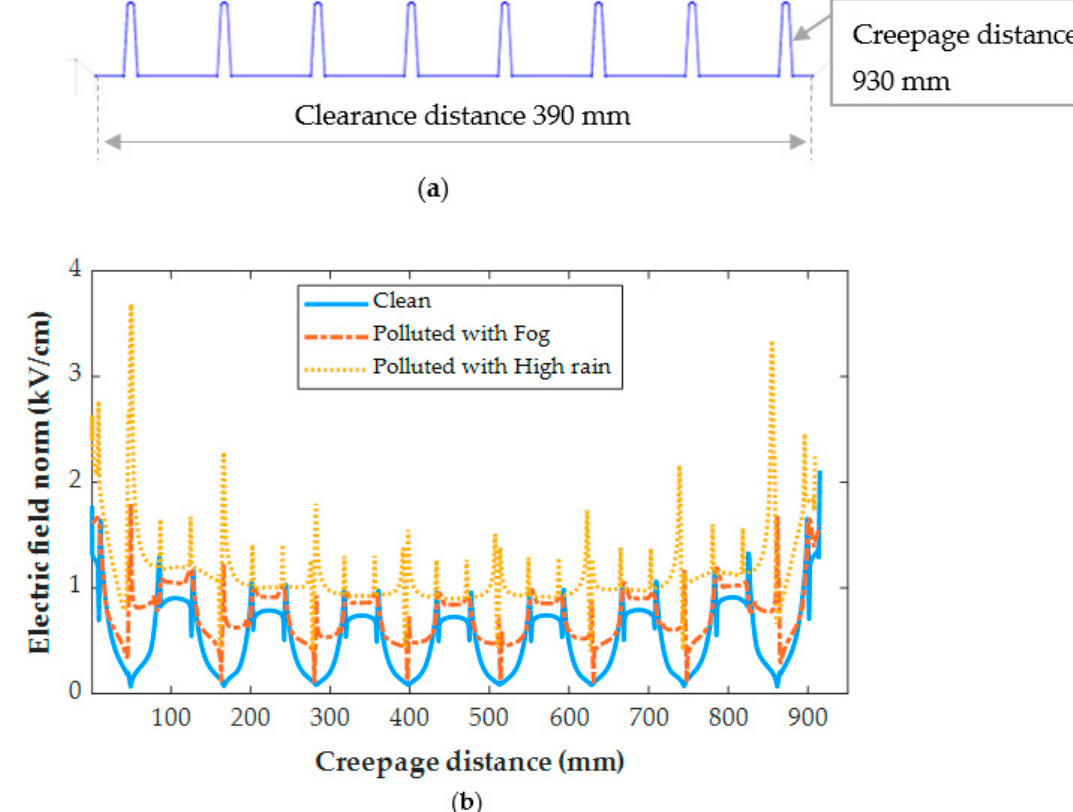
Figure 16. ( a ) Electric field path for insulator type I; ( b ) Electric field distribution for insulator type I under clean, polluted with fog, and polluted high rain conditions.